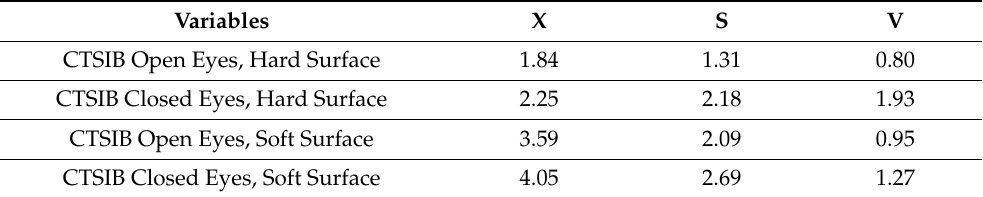
Table 2. The Clinical Test of Sensory Integration and Balance in girls with scoliosis.